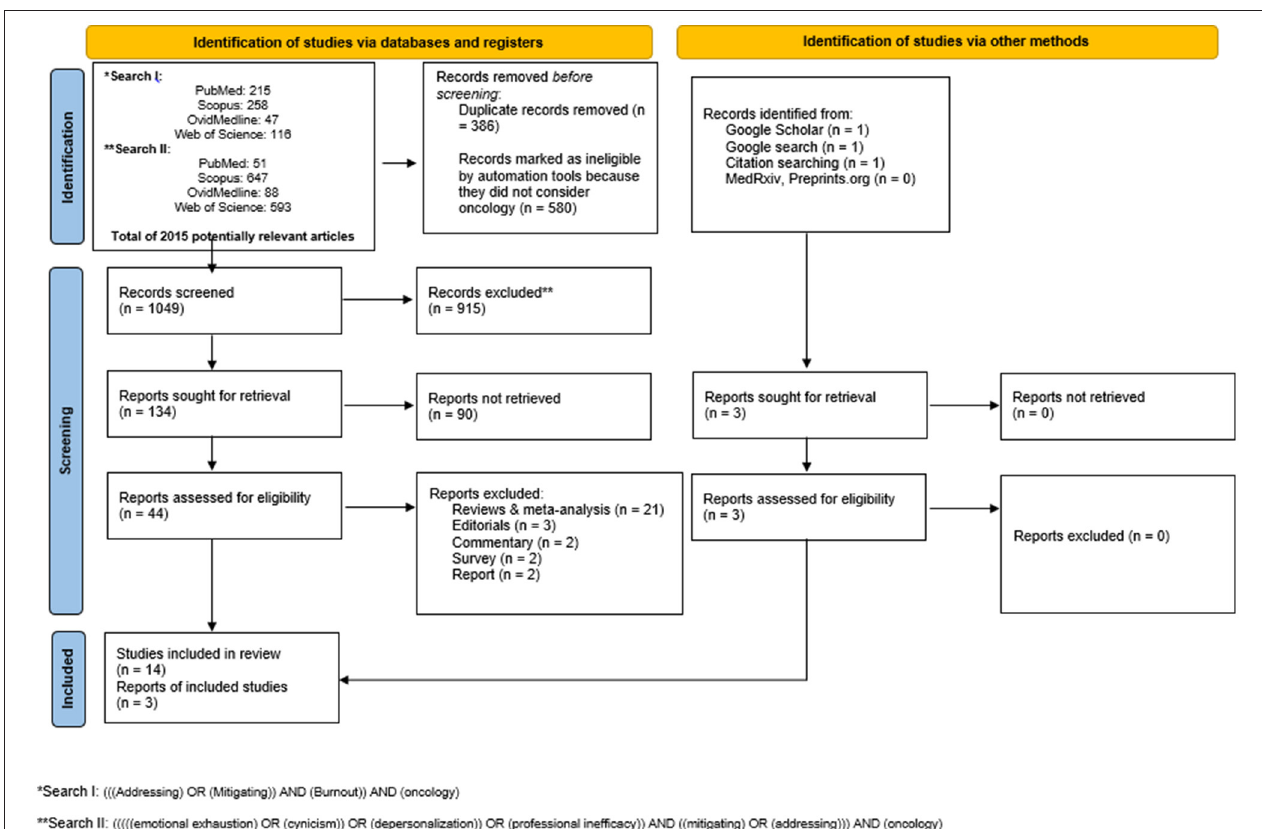
FIGURE 1 | The Preferred Reporting Items for Systematic Review and Meta-Analysis (PRISMA) flow diagram highlighting the search strategy and the search results.